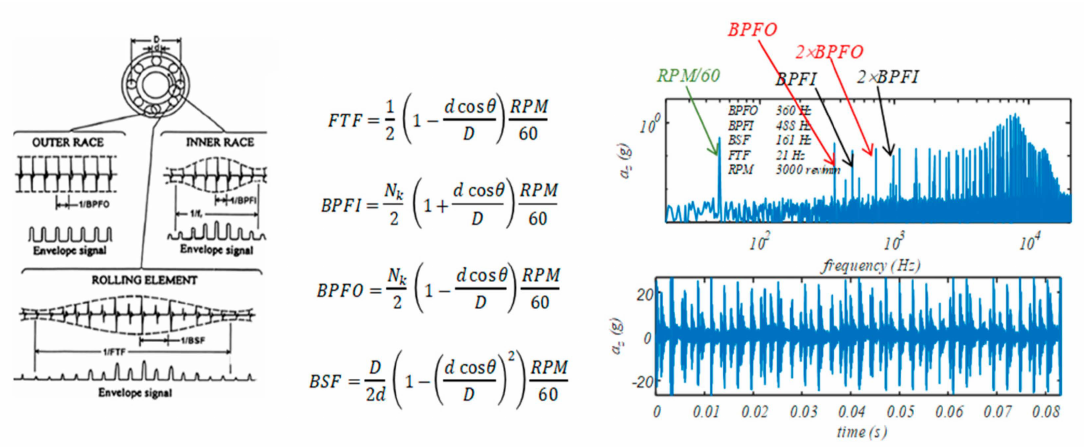
Figure 2. Example of characteristic rolling bearings frequency, and a typical time–frequency analysis. Left figure from [40].